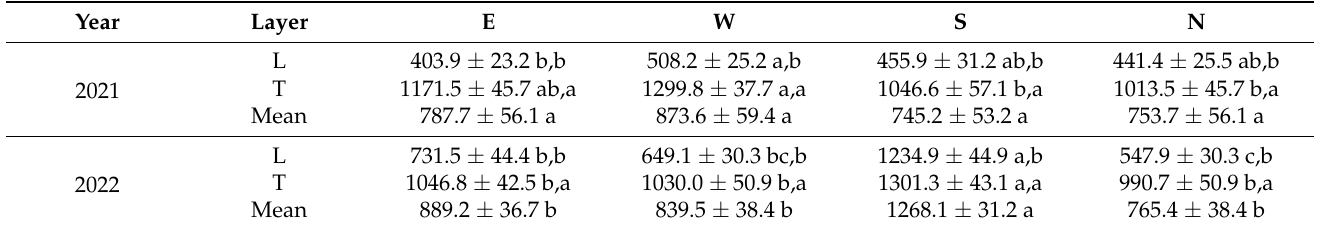
Table 1. PAR inside the canopy of almond trees ( µ mol m − 2 s − 1 ) at DOY 225 for year 2021 and DOY 229 for 2022, in different expositions (E, W, S, N: East, West, North, South) into two different layers: low (L; 0.5–1.4 m) and top (T; 1.4–2.3 m). The first letters denote statistical differences among row expositions; the second letters denote statistical differences between layers ( p = 0.05; SNK test).